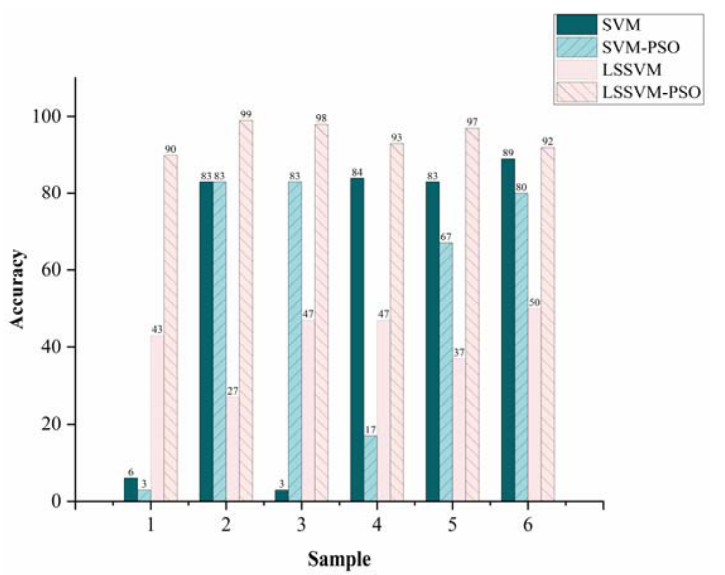
Figure 7. Model classification results after parameter optimization for the six kinds of aviation alloy samples.